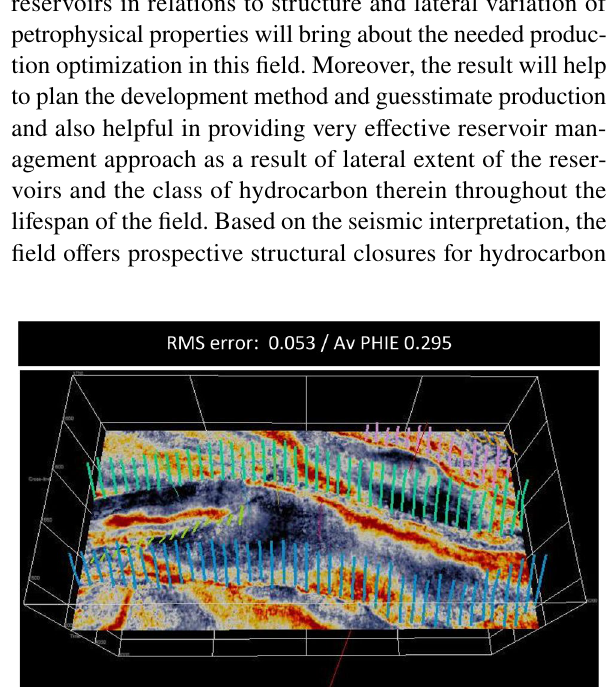
Fig. 13 a RMS Amplitude map of top of PENNAY horizon 2 show- ing. b : 3D view of depth structural map of PENNAY horizons. c RMS Amplitude map of top of PENNAY horizon 2 showing regions of interest, interrelationship of faults and well locations. d Instanta- neous frequency of top of PENNAY horizon 2. e Relative acoustic impedance of top of PENNAY horizon 2. f Reflection intensity of top of PENNAY horizon 2. g Normalized amplitude of top of PENNAY horizon 2